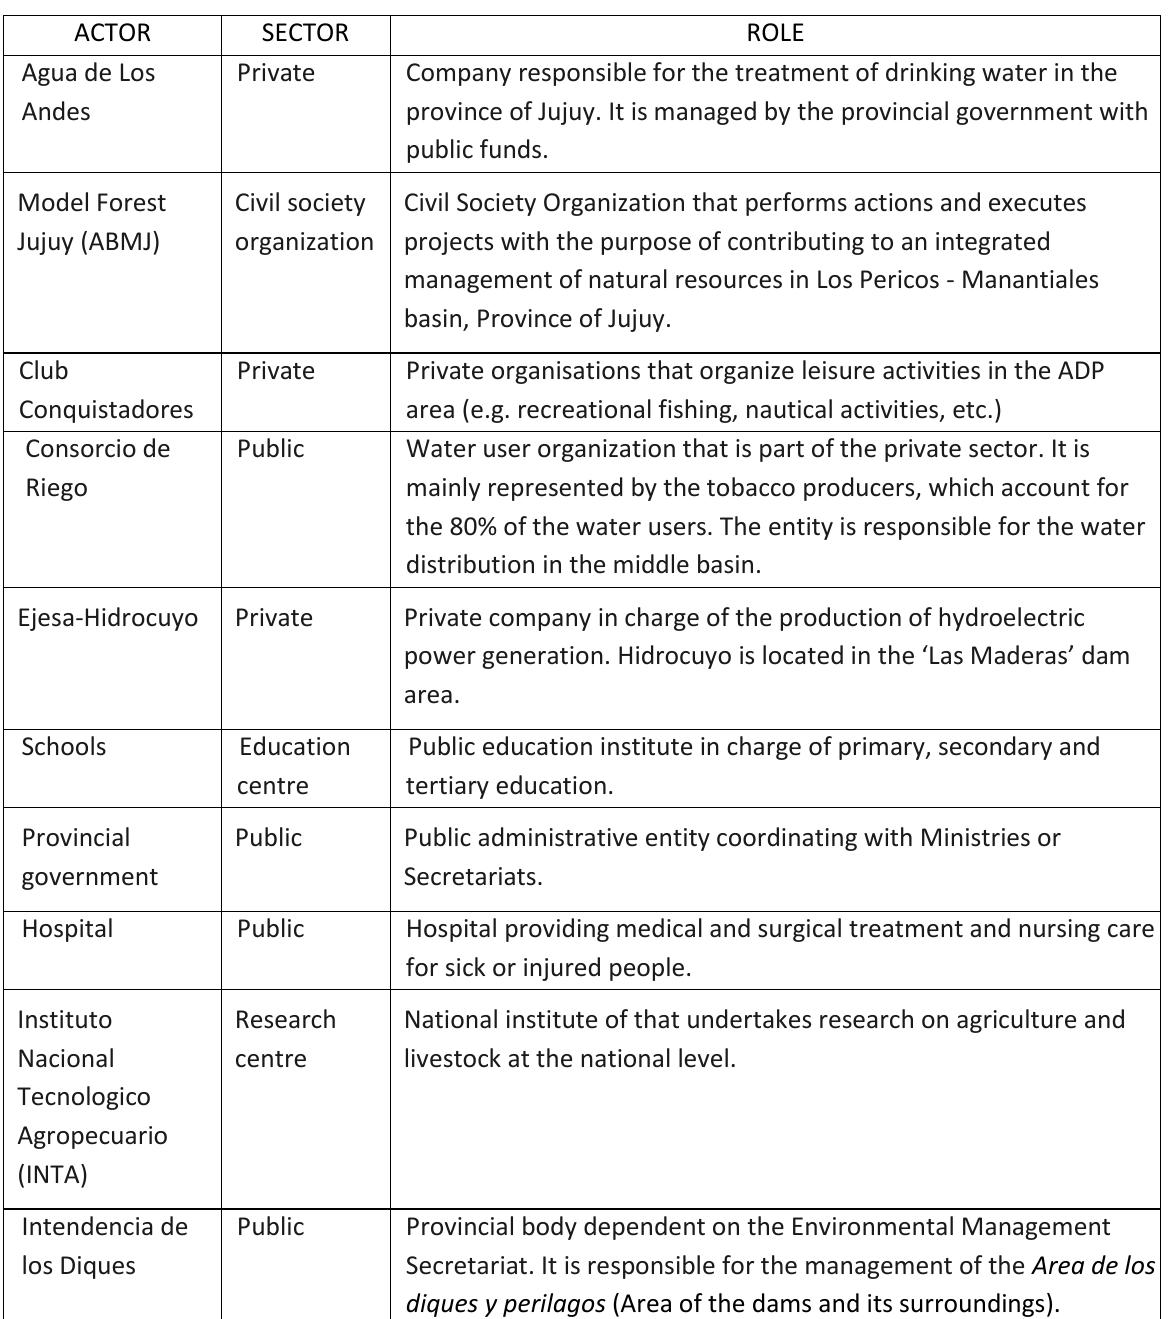
Table A3.1. Main actors and perceived roles in the water governance network of the Jujuy Model